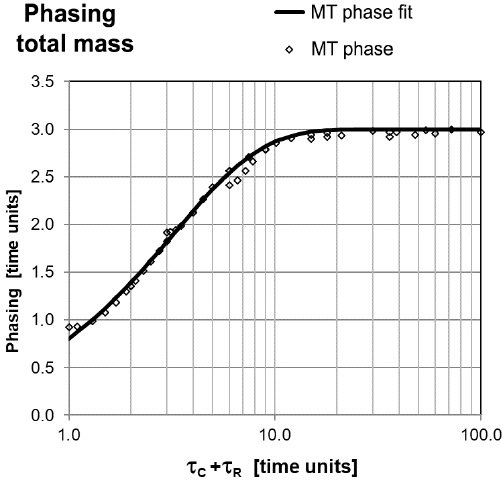
Figure 5. Phasing of river network mass with respect to recharge time series displayed versus τ C for different τ R .